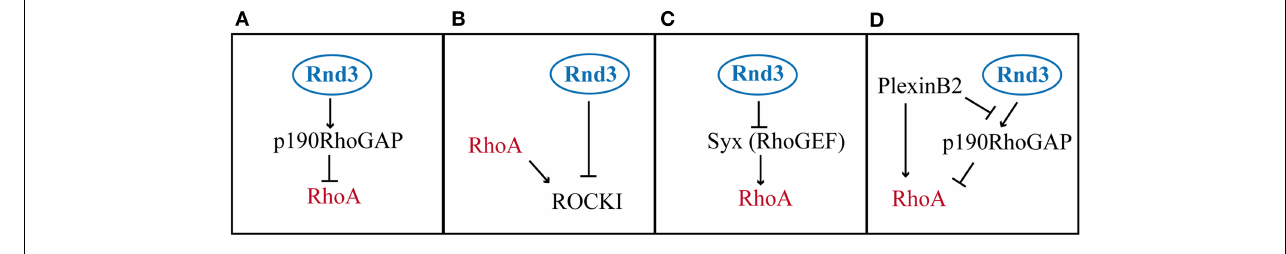
FIGURE 4 | Modes of RhoA activity regulation by Rnd3. (A) Rnd3 interacts with p190RhoGAP and promotes its activity of RhoA inactivation. (B) Rnd3 indirectly inhibits RhoA signaling, by blocking the RhoA downstream effector ROCKI. (C) Rnd3 inhibits a RhoA